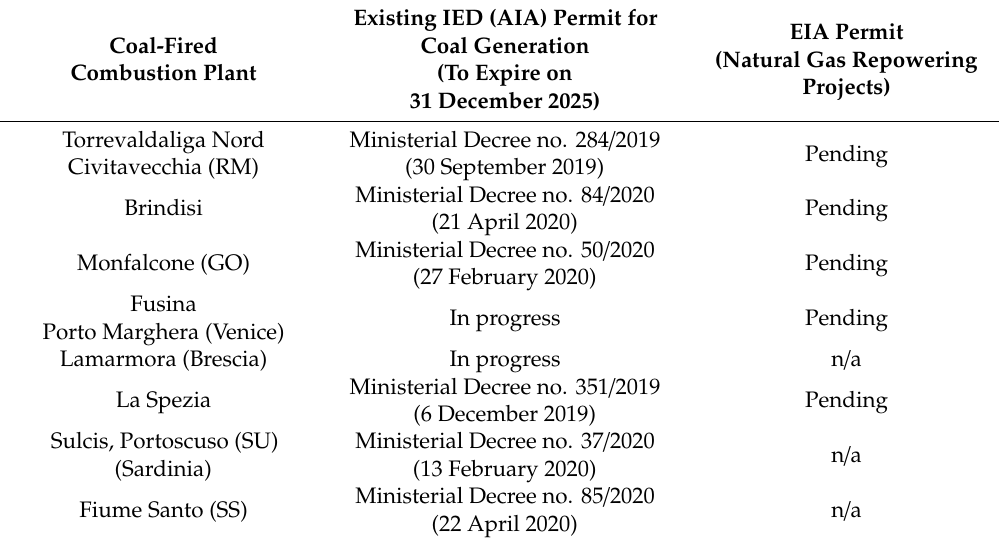
Table 9. State of the art of Autorizzazione Integrata Ambientale (AIA) permitting procedures for existing coal-fired power plants [15].